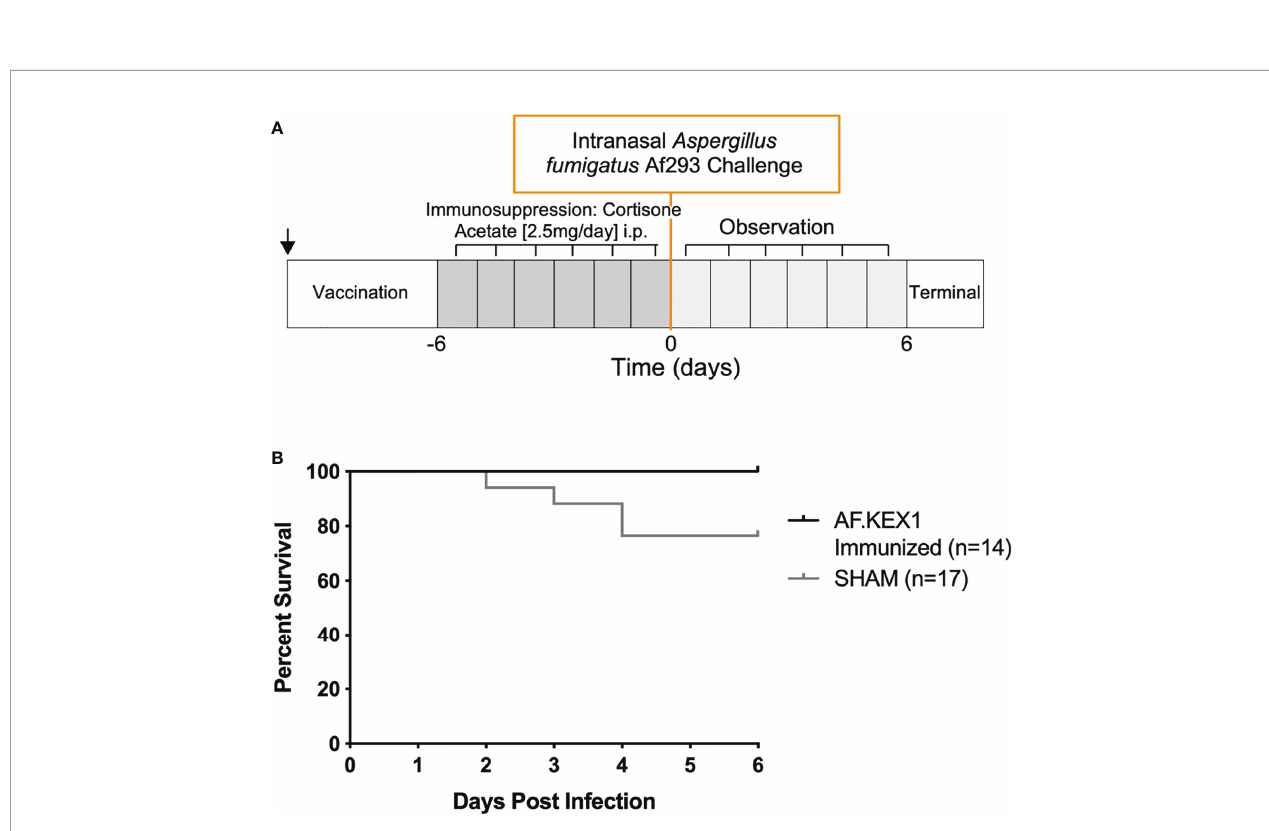
FIGURE 5 | Invasive pulmonary aspergillosis in steroid immunosuppression model. (A) Challenge study design. (B) Survival curve of AF.KEX1-immunized animals, compared with SHAM. AF.KEX1-immunized animals were signi fi cantly protected from developing Aspergillosis when immunosuppressed with cortisone acetate, compared with sham-immunized controls ( p =.0487, by Mantel-Cox test). Immunization is indicated by